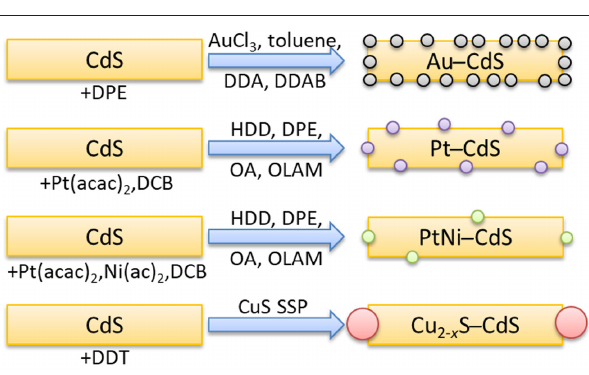
SCHEME 1 | General schematics of the synthetic methods used to grow the different described metal and Cu 2 − x S domains on CdS